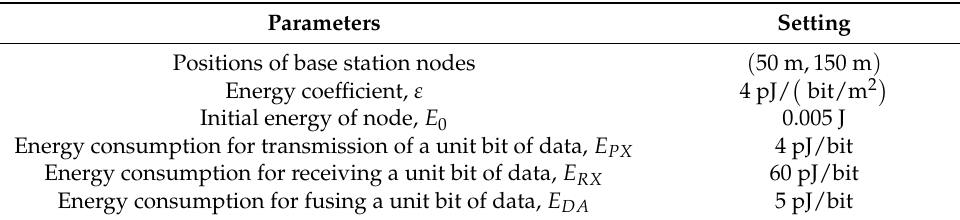
Table 1. Simulation parameters.